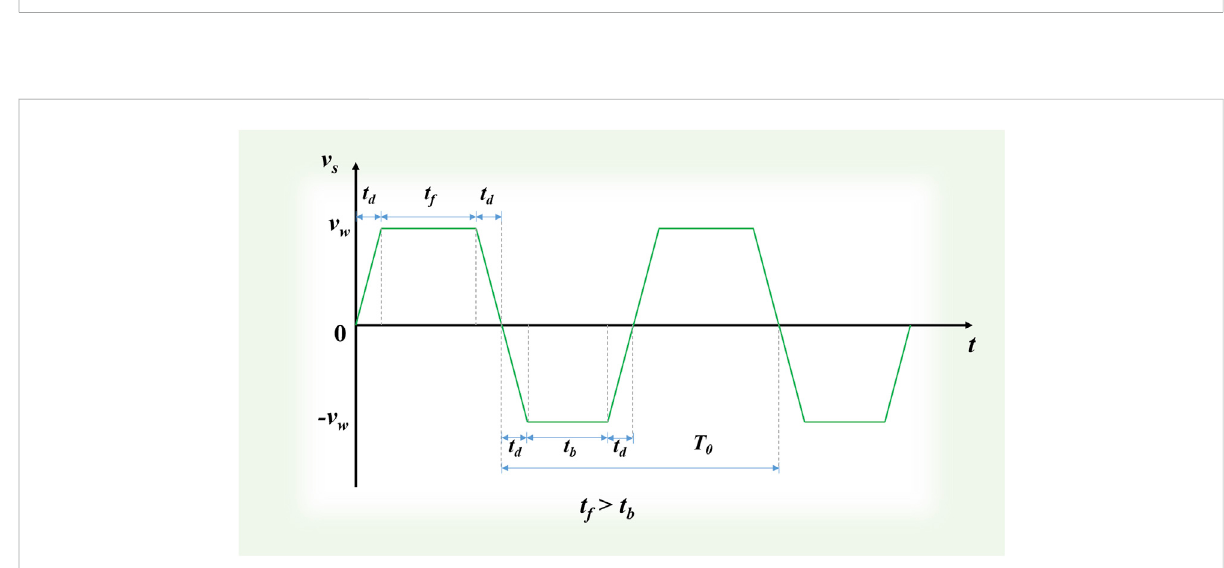
FIGURE 2 The wire saw speed changing with time during the multi-wire saw